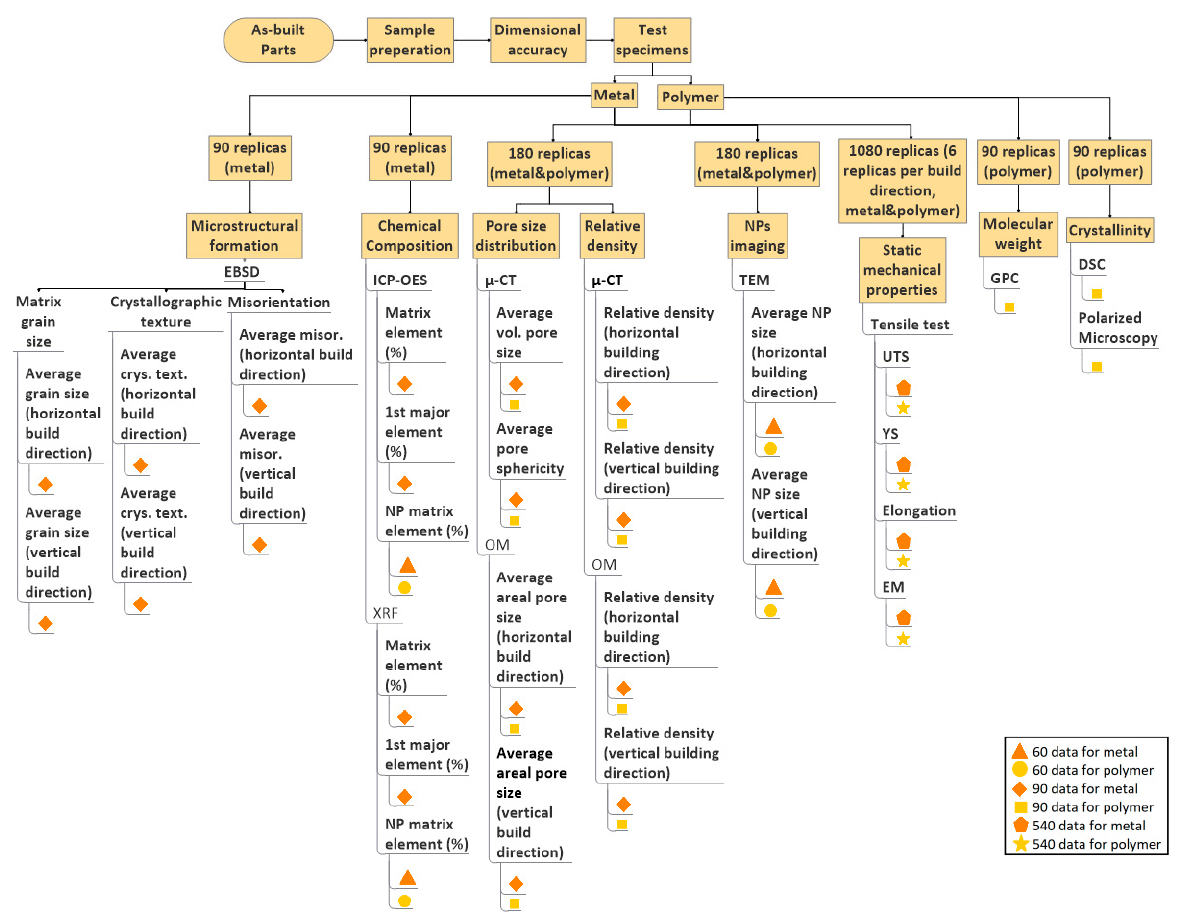
Figure 6. As-built part property analysis with related measurement techniques for nanoparticle-additivated metal and polymer parts, number of replicas for each property measurements per build job, and number of data generated for each property metric. Electron backscattered diffraction (EBSD), inductively coupled plasma-optical emission spectroscopy (ICP-OES); X-ray fluorescence (XRF); micro-computer tomography (µ-CT); optical microscope (OM); transmission electron microscope (TEM); ultimate tensile strength (UTS); yield strength (YS); elastic modulus (EM); gel permeation chromatography (GPC); differential scanning calorimetry (DSC).